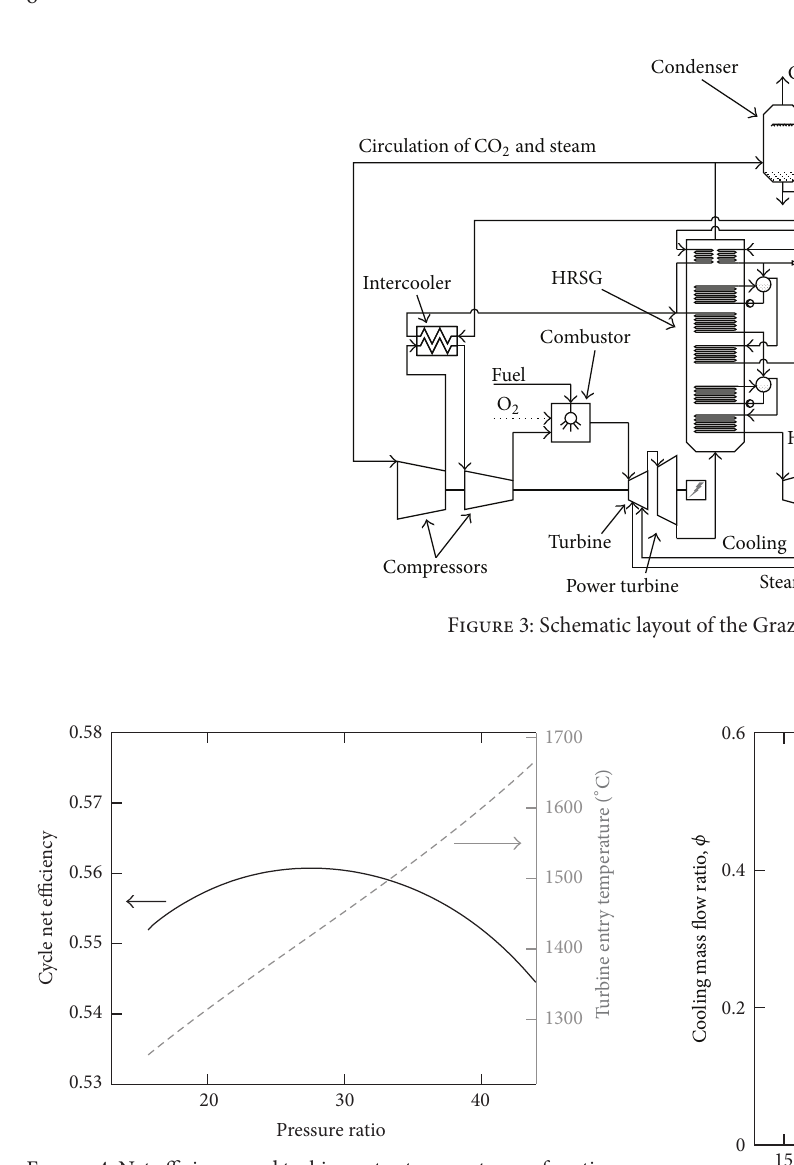
Figure 4: Net efficiency and turbine entry temperature as functions of pressure ratio for the reference cycle.